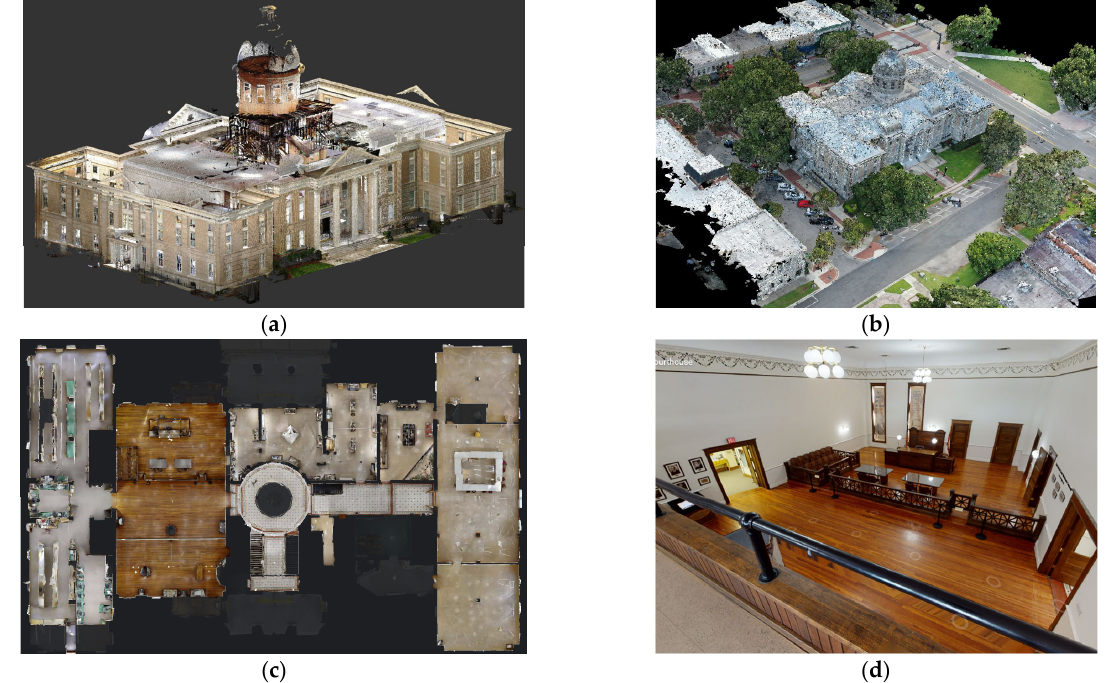
Figure 26. Demonstration of the HBIM “Visual Representation” supplement to LOD 100: ( a ) “cleaned” TLS point cloud; ( b ) UAV photogrammetric point cloud; ( c ) second floor plan of the virtual tour (the 1908 courtroom is visible with solid wood flooring); ( d ) view from third floor balcony of the 1908 courtroom in the virtual tour.